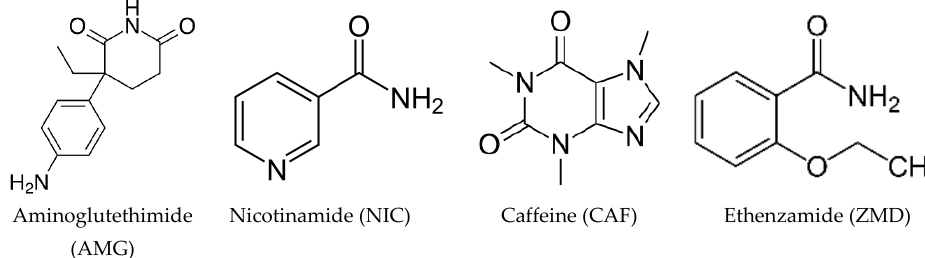
Scheme 1. Molecular structure of Aminoglutethimide and the coformers selected for the